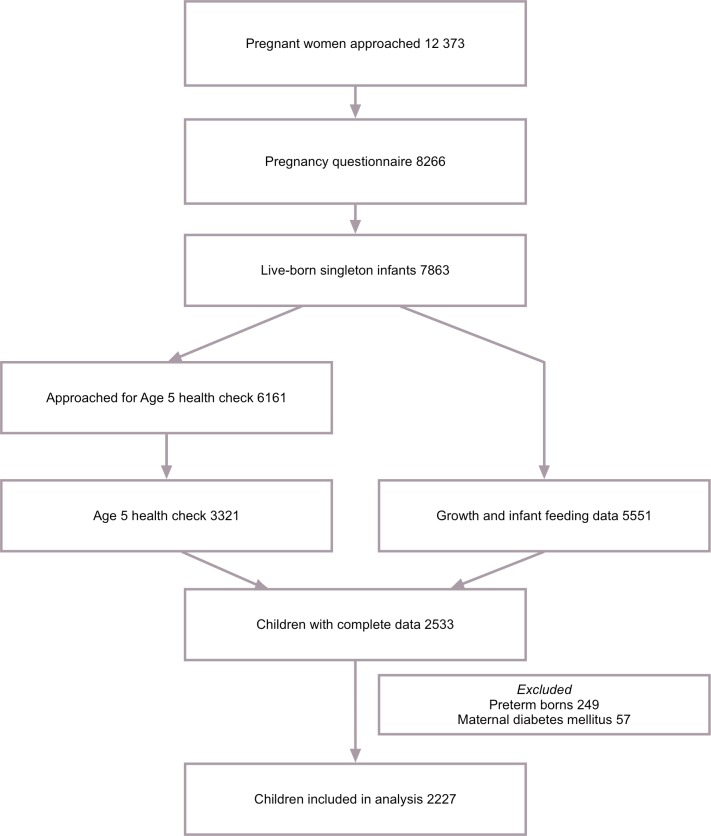
Sampling procedure.